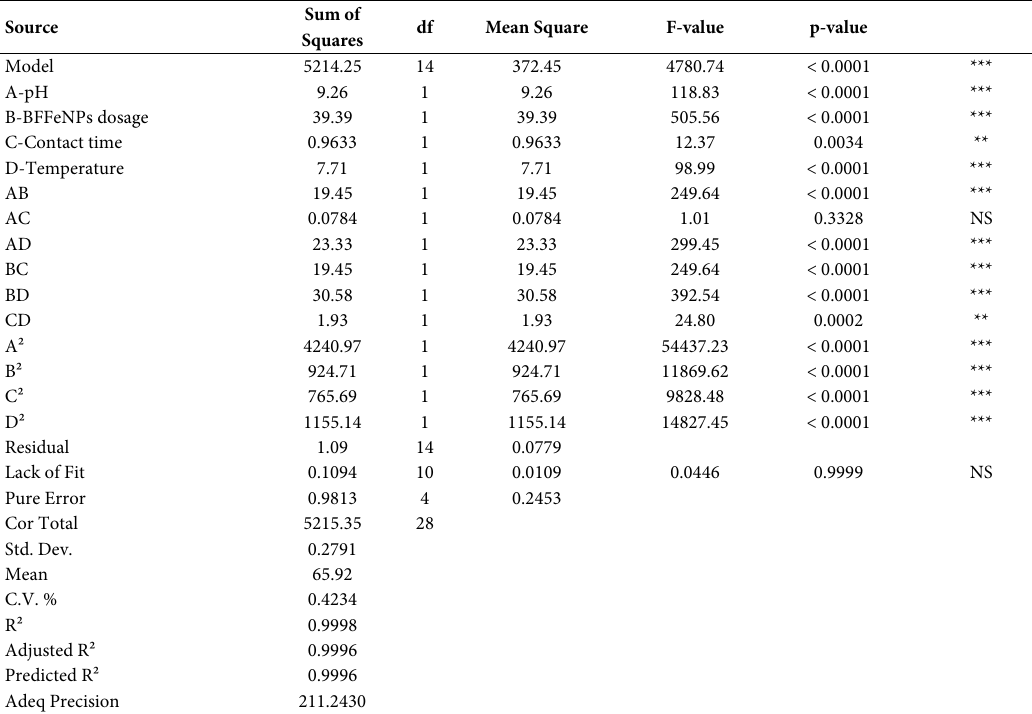
Table 3. ANOVA for response surface quadratic model (Response Pb II %